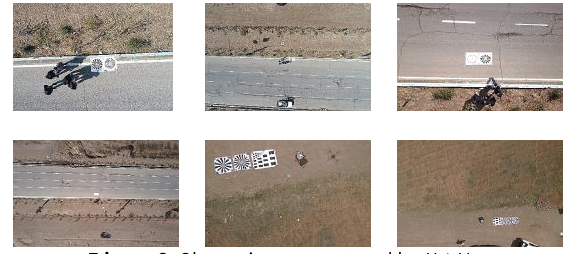
Figure 8. Shows images captured by UAVs.